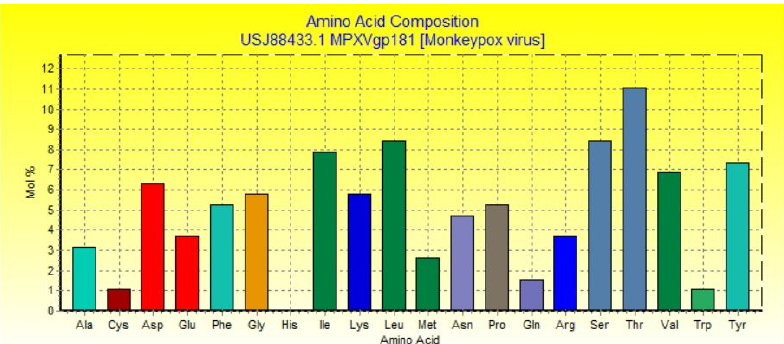
Figure 1. Transmembrane helices prediction in MPXVgp181 protein by TMHMM.